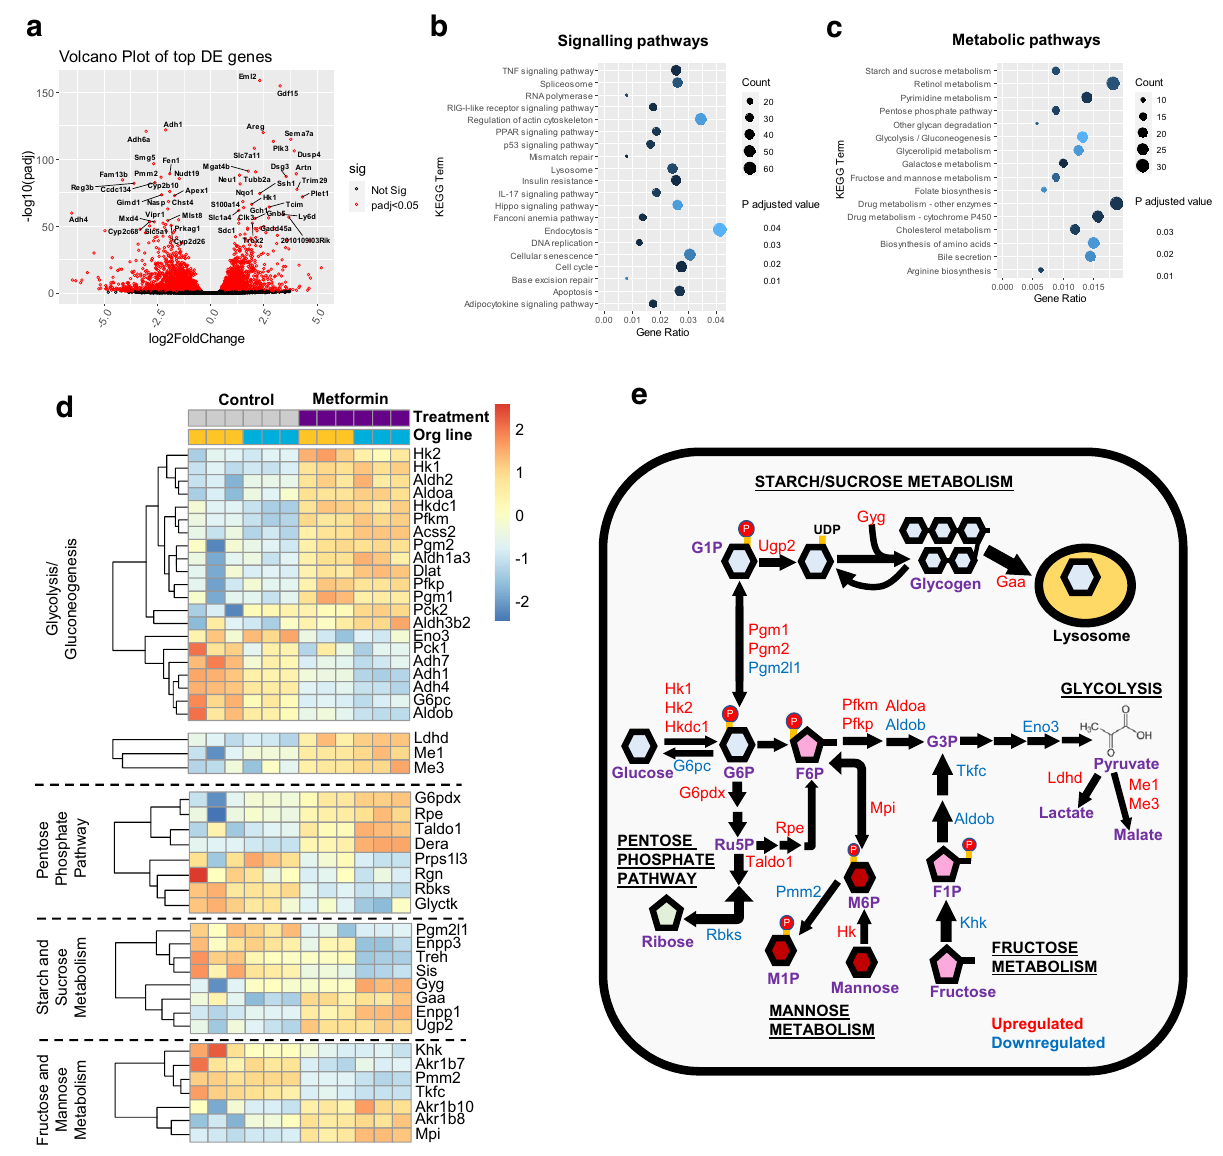
Figure 1. The effects of metformin on differentially expressed (DE) genes and metabolic pathways in mouse intestinal monolayer cultures. ( a ) Volcano plot displaying gene expression changes in duodenal organoid cells in 2D monolayer cultures treated with 1 mM metformin or no treatment control (n = 6 plates per condition from 2 different organoid lines). Fold-change (X-axis) compared to p-adjusted values (Y-axis) of individual genes altered by metformin treatment. Red dots represent DE genes (P < 0.05); black dots represent gene expression changes that were not statistically significant (Not Sig). Labelled genes represent the top 50 DE genes (sorted by P values). Analysis was performed using Bioconductor software packages in RStudio (v.1.2.5019), with gene annotation from the Ensembl dataset in BioMart (v2.40.5). Volcano plots were generated using the Geompoint function of the ggplot package. ( b , c ) KEGG enrichment analysis for changes in signalling ( b ) and metabolic ( c ) pathways affected by metformin treatment. Gene ratio is the number of DE genes in a KEGG pathway divided by total number of genes in the pathway. Count represents the numbers of DE genes. KEGG pathway analysis was performed using clusterprofiler. ( d ) Heatmaps showing DE genes (filtered by p-adjusted value < 0.05) involved in hexose metabolism. Relative expression is normalised to z-scores for each gene. Each box indicates a separate plate and the corresponding organoid line. Heatmaps were plotted using Pheatmap. ( e ) Schematic showing expression changes of genes involved in all hexose metabolism pathways. Red and blue show upregulated and downregulated genes,